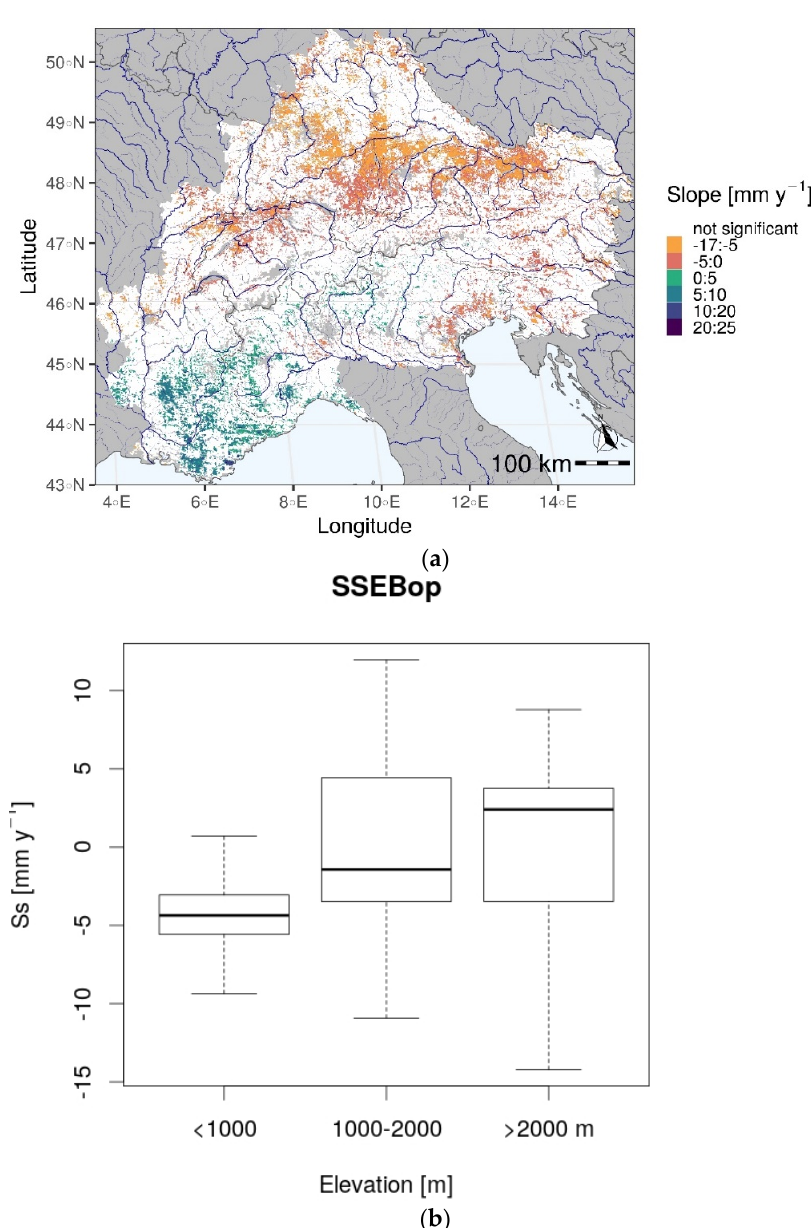
Figure 3. Sen’s slope of the trend at 5% significance level for yearly ET from the SSEBop product ( a ); boxplot of the distribution of the slope (Ss) with elevation ( b ). The period of investigation is 2003–2019.